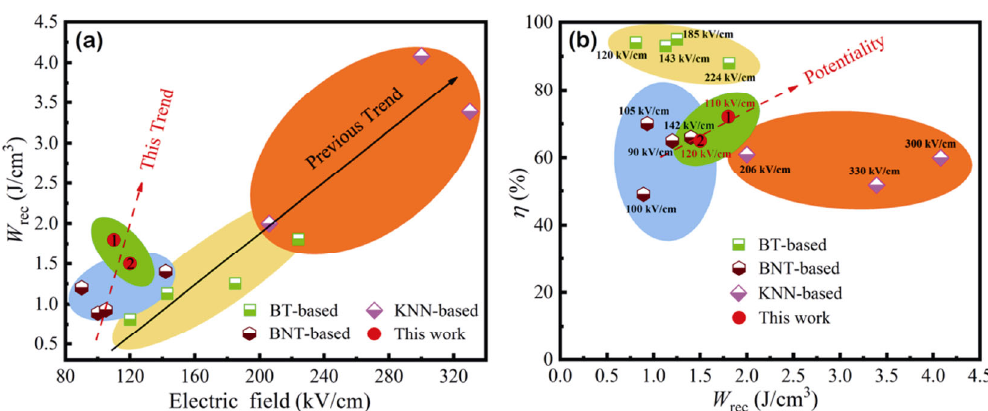
Fig. 9 A comparison of energy storage properties ( W rec and  ) between some reported lead-free ferroelectric ceramics and this work. Note that 1 and 2 in the red ball denote the x = 0.06 and x = 0.08 compositions in this work,